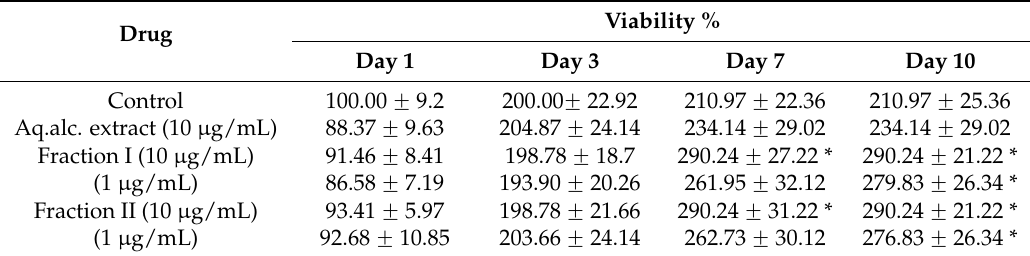
Table 3. The proliferation-enhancing activity of Erythrina crista-galli in MCF-7 cells using the SRB assay relative to the control.